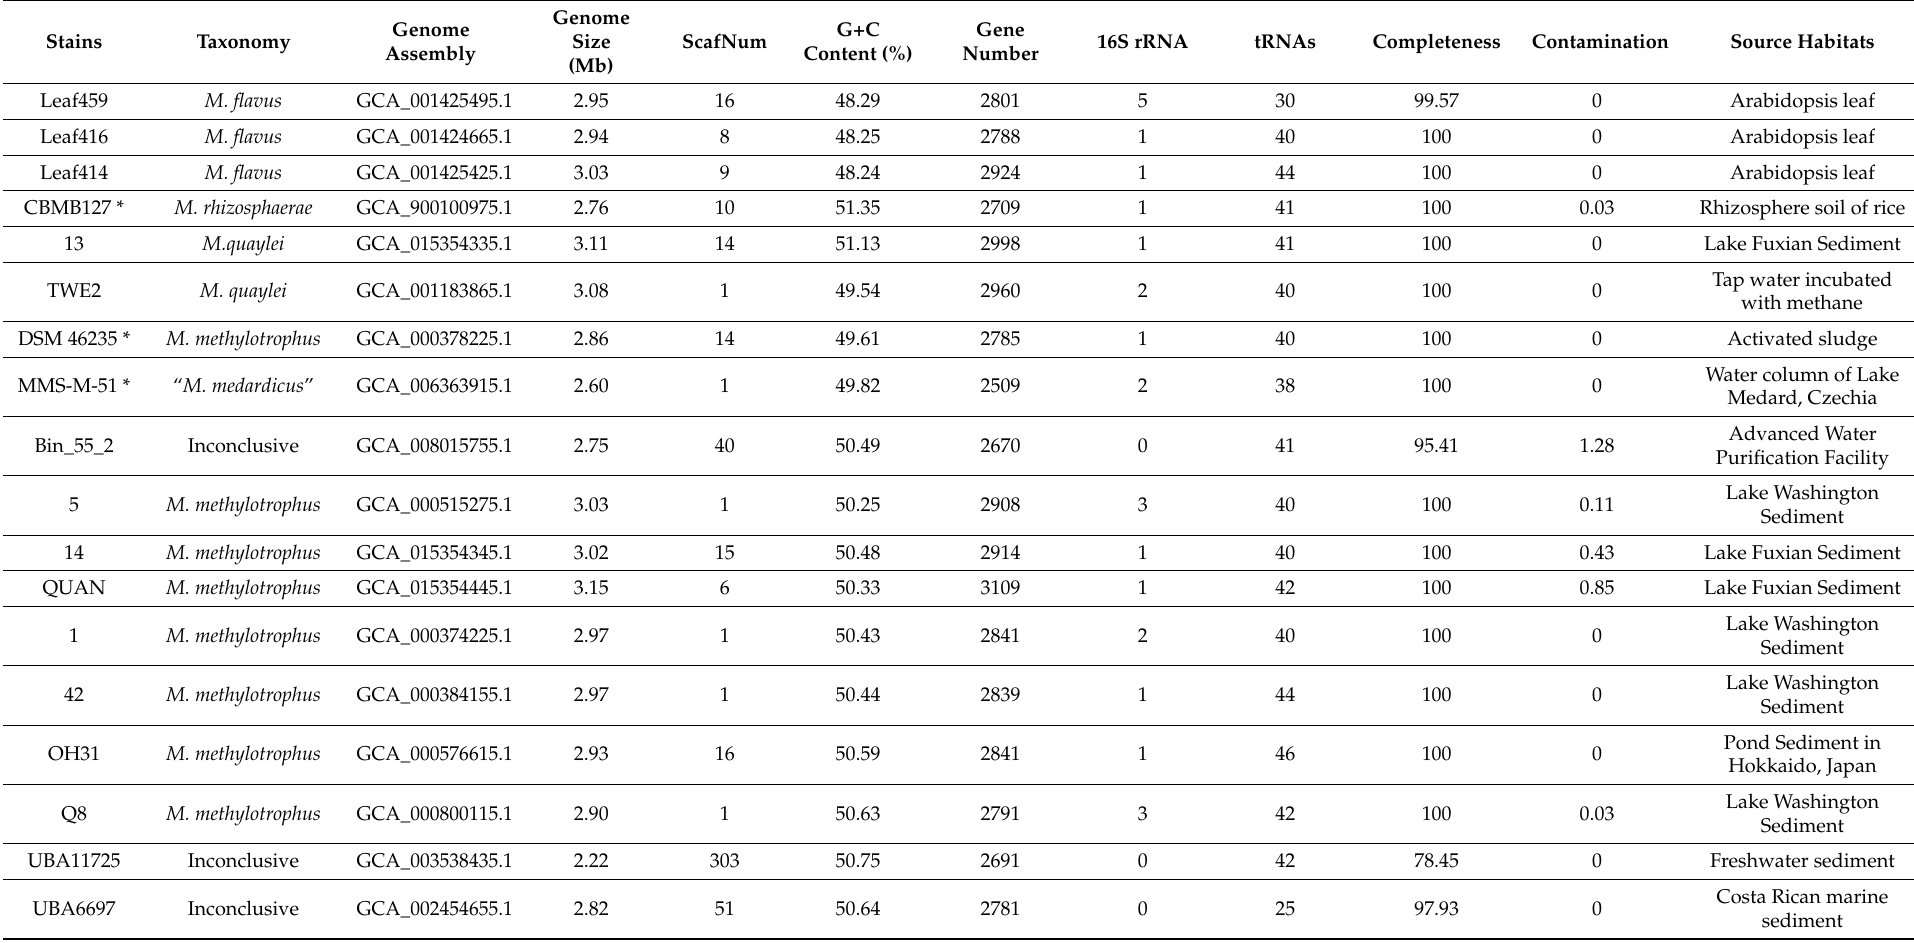
Table 1. General features of the genomes within the genus Methylophilus